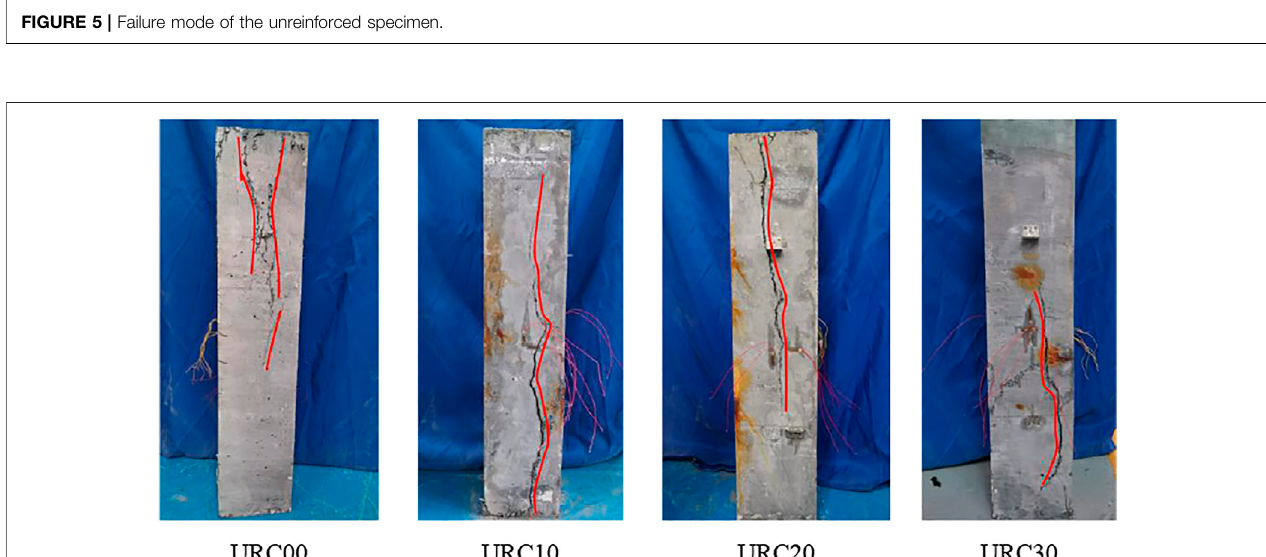
FIGURE 6 | Failure mode of the strengthened